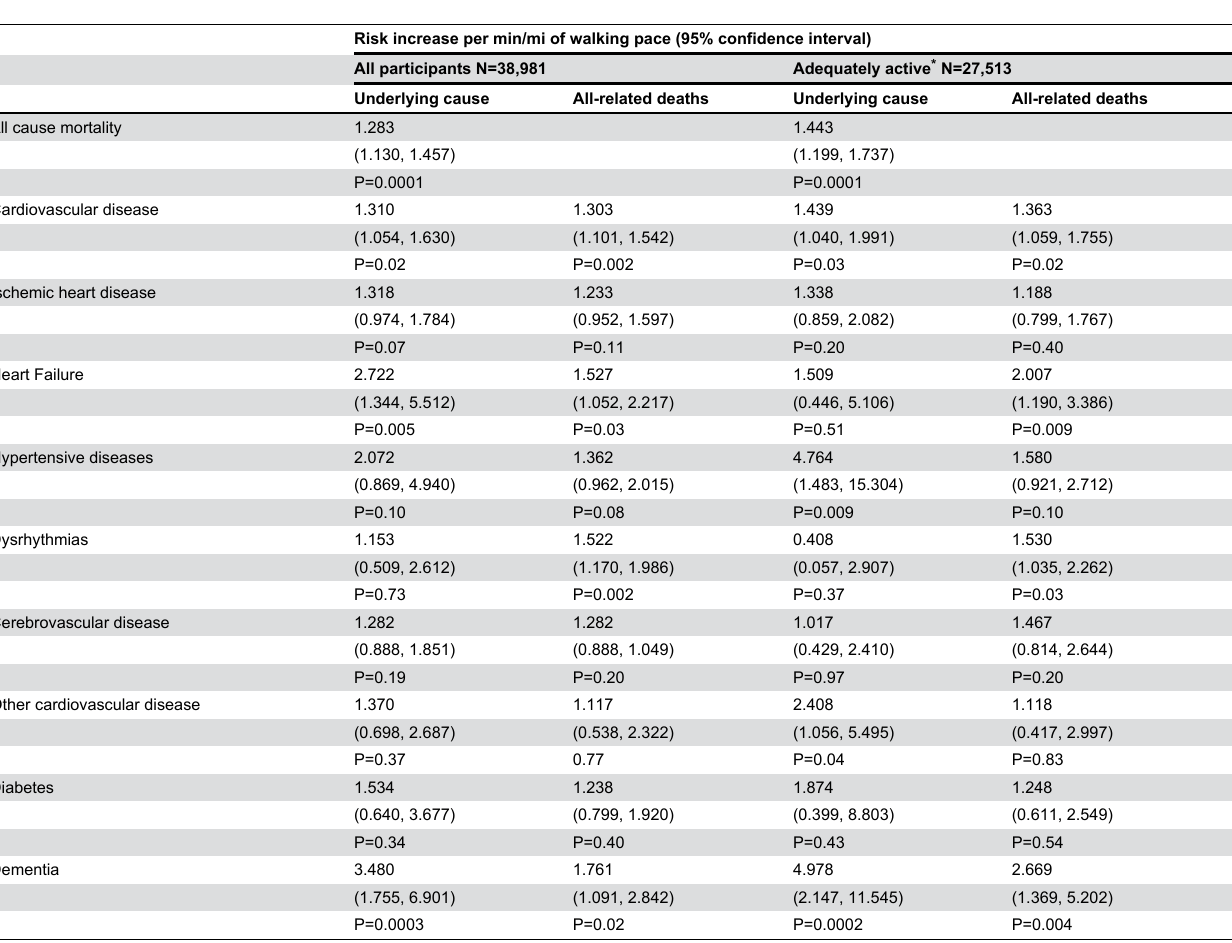
Table 5. Hazard ratios for walking slower than 24.19 minutes per mile (corresponding to ≤400m during a 6 minute walk test) vs. faster pace in participants of the National Walkers’ Health